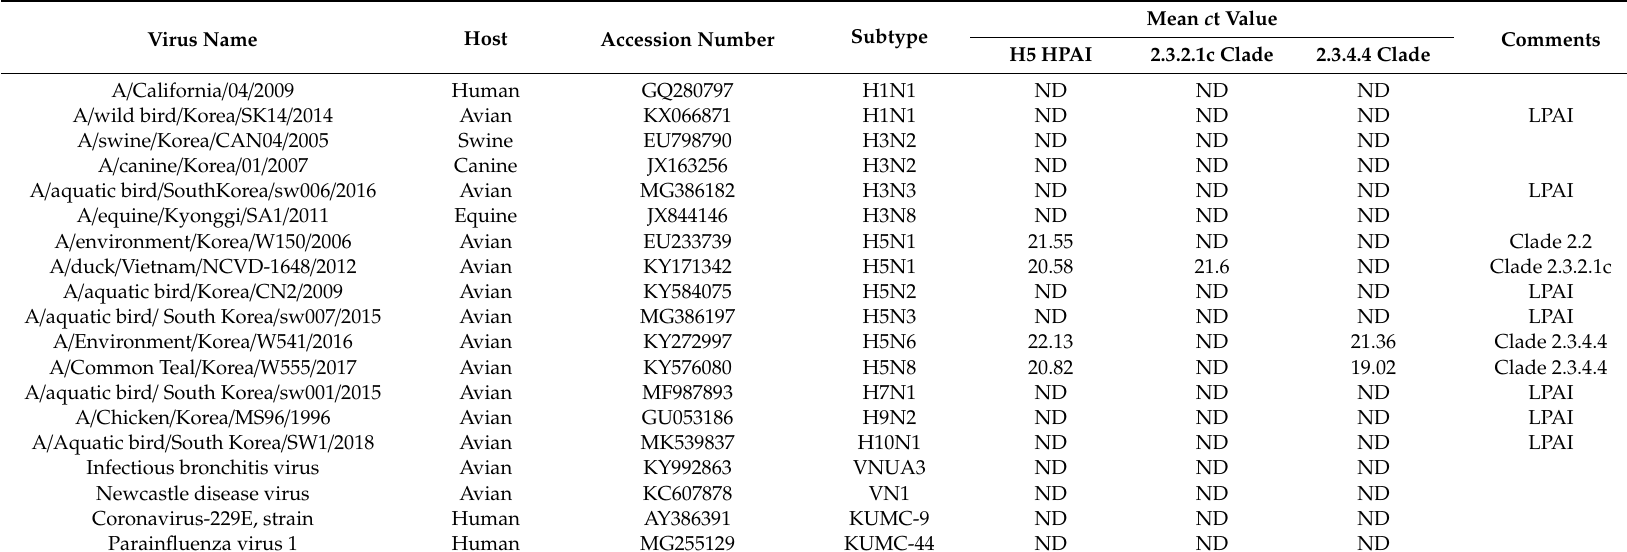
Table 2. Reference virus strains used for specificity analysis of the developed